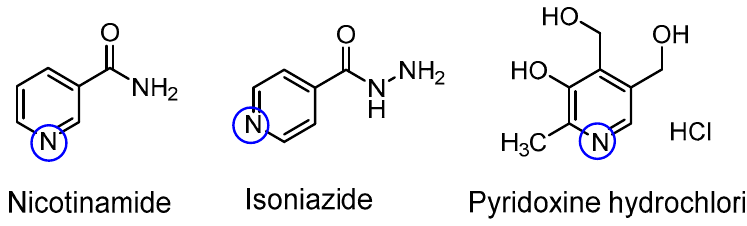
Figure 1. p Ka values of the nicotinamide, isoniazid, and pyridoxine hydrochloride were determined.